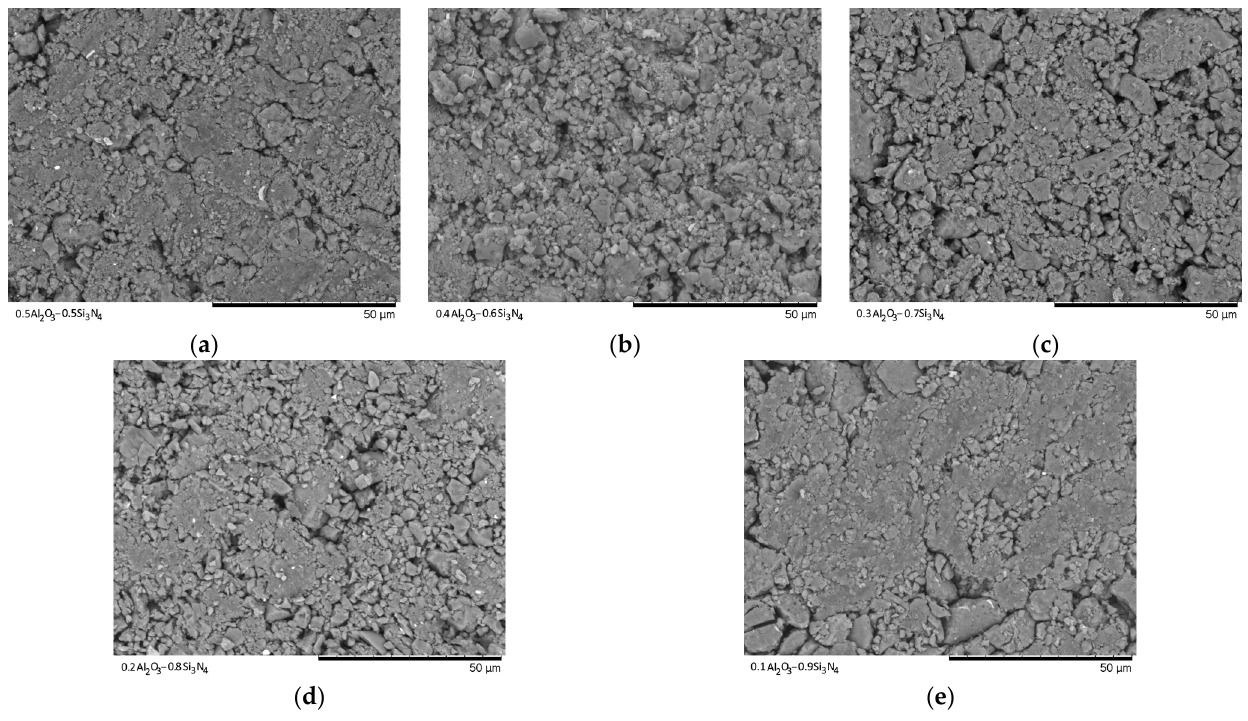
Figure 9. SEM images of synthesized ceramics in Secondary electron image mode: ( a ) 0.5Al 2 O 3 –0.5Si 3 N 4 ; ( b ) 0.4Al 2 O 3 –0.6Si 3 N 4 ; ( c ) 0.3Al 2 O 3 –0.7Si 3 N 4 ; ( d ) 0.2Al 2 O 3 –0.8Si 3 N 4 ; ( e ) 0.1Al 2 O 3 –0.9Si 3 N 4 .